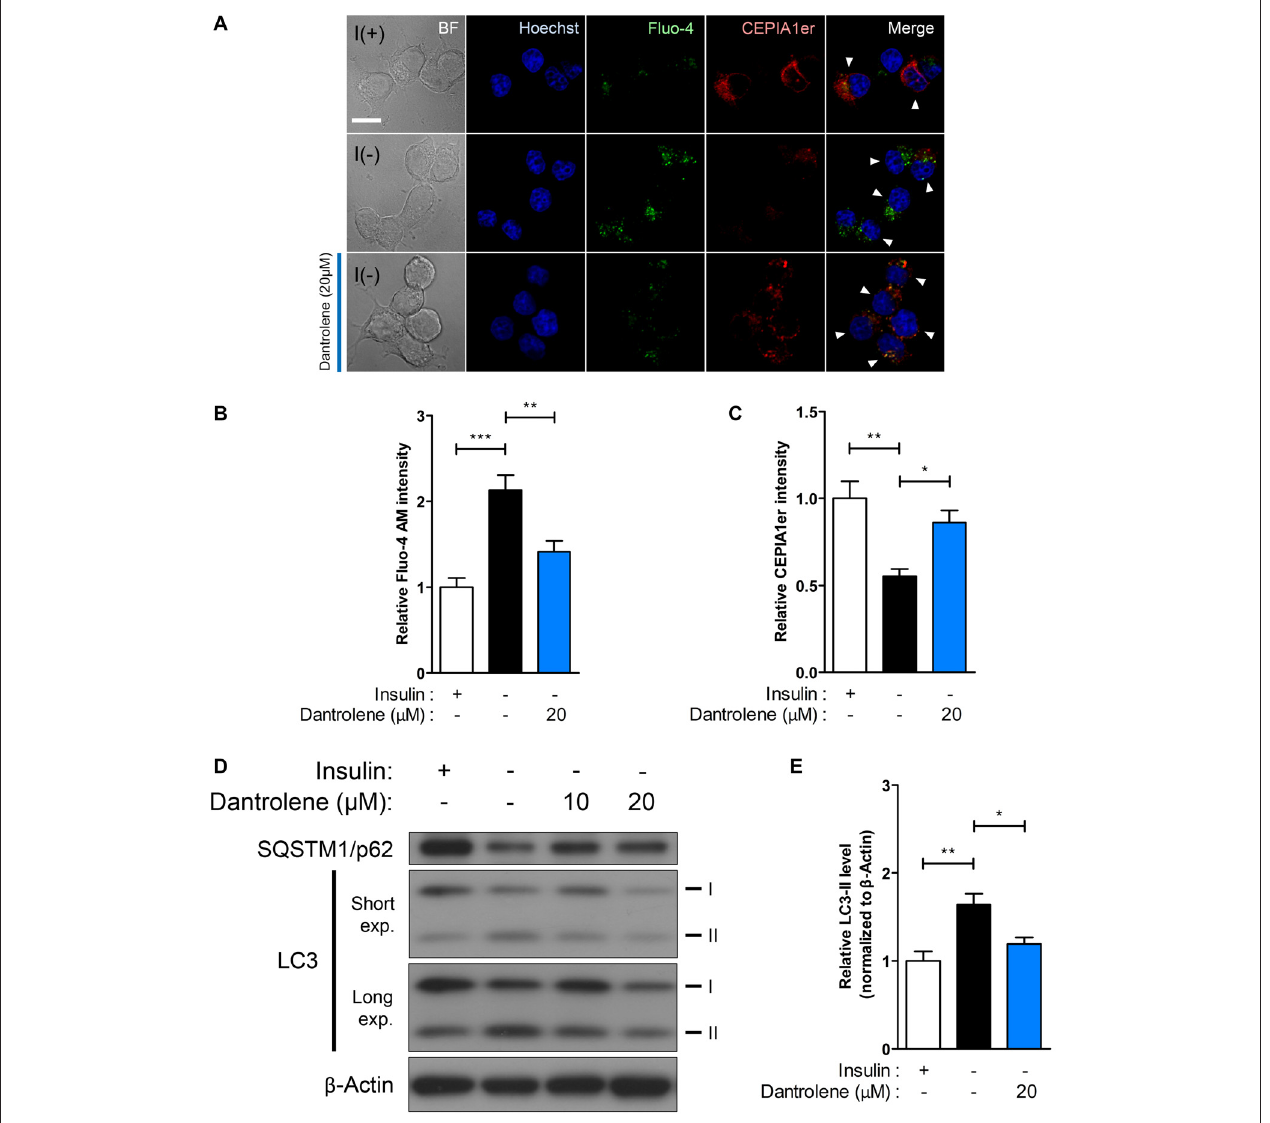
FIGURE 5 | RyR inhibition suppresses ACD in HCN cells. (A–E) Treatment with the RyR antagonist dantrolene inhibits autophagic activity in HCN cells. (A) Immunofluorescence-based detection of Fluo-4 AM and pCMV R-CEPIA1er in I( − ) HCN cells treated with dantrolene. Cells subjected to analysis are indicated by arrowheads. Scale bar, 10 µ m. Fluorescence intensities of Fluo-4 AM (B) and CEPIA1er (C) in HCN cells were quantified ( n = 22 for I(+), 30 for I( − ), 27 for I( − )/Dantrolene). (D) Western blot analysis of LC3 and SQSTM1/p62 in I( − ) HCN cells treated with dantrolene for 6 h. The signal intensity of LC3-II was quantified in (E) using the ImageJ software and normalized to β -actin ( n = 6). The bars represent the mean ± SEM; ∗ p < 0.05, ∗∗ p < 0.01, ∗∗∗ p <